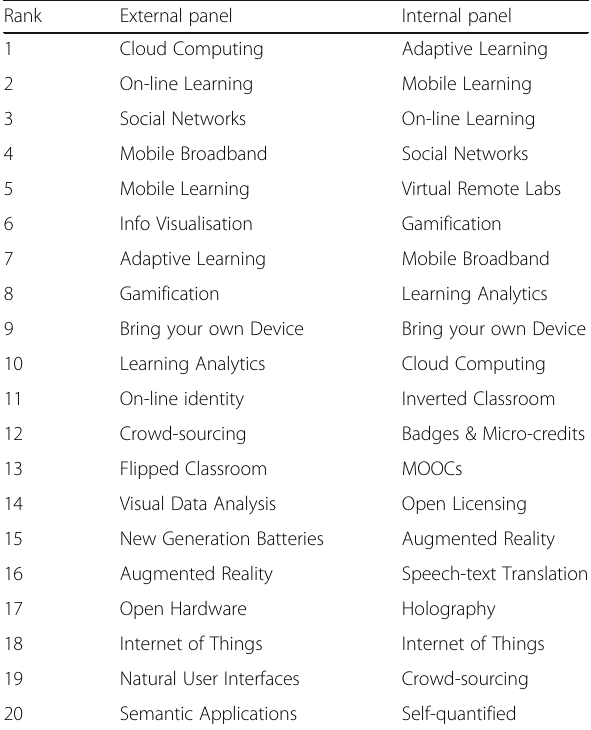
Table 3 New technologies ranking sorted by relevance